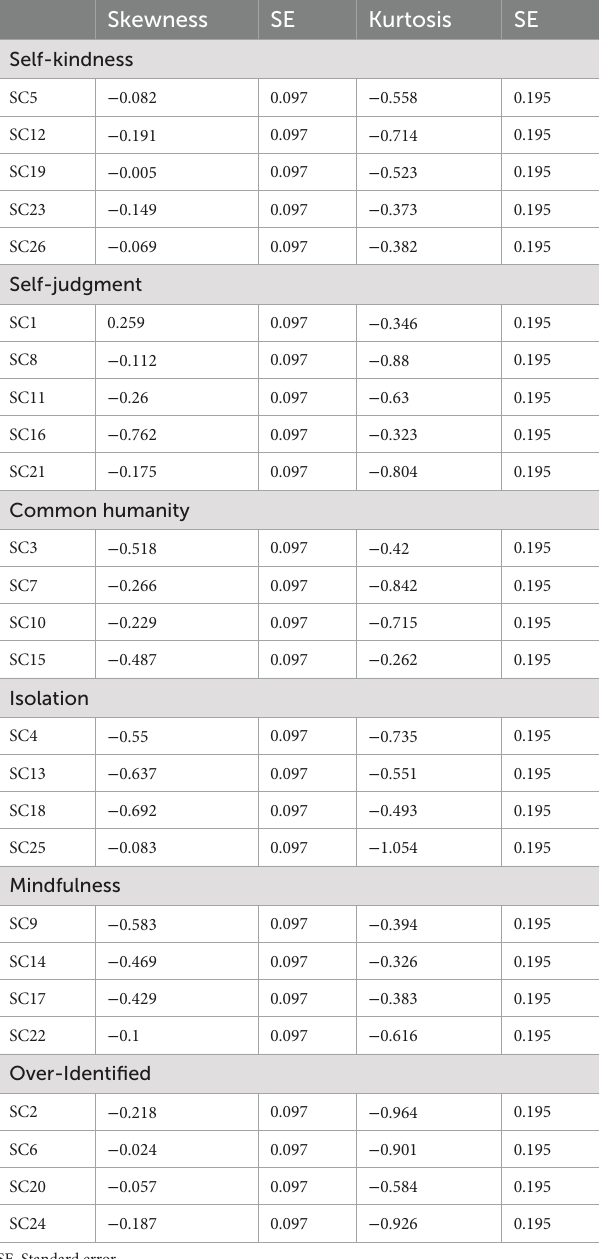
TABLE 2 Skewness and kurtosis